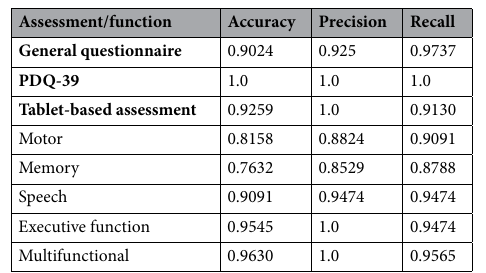
Table 2. Accuracy, precision, recall for classification of individuals with PD and control populations for overall assessments and subfunctional neurocognitive